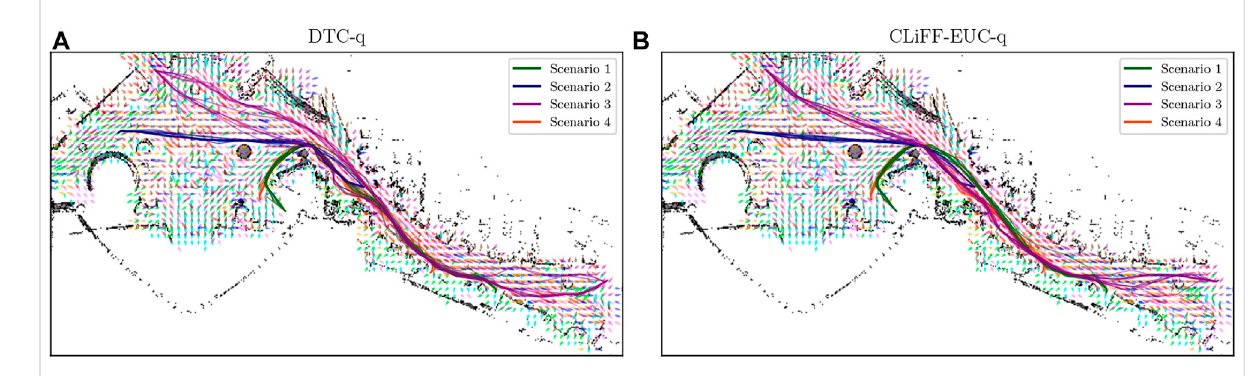
FIGURE 6 The CLiFF-maps and paths generated by the DTC-q (A) and CLiFF-EUC-q (B) planners in the ATC